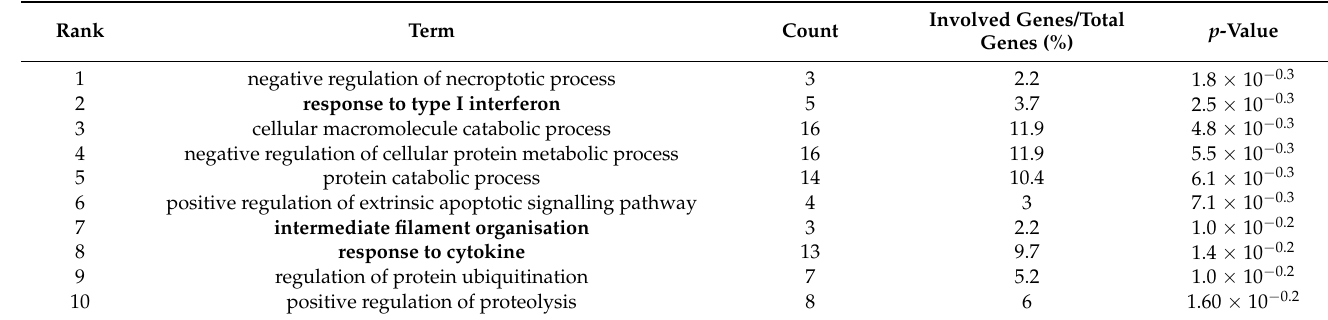
Table 2. Top 10 gene ontology biological functions for proteins with decreased or increased abun- dances in CaOV3 cells. Terms in bold represent those which are represented in both OVCAR-5 and CaOV3